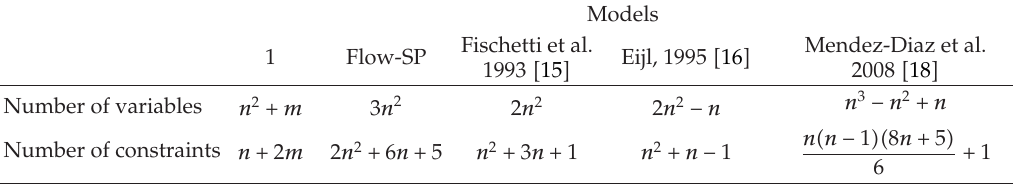
Table 2: Total number of decision variables and constraints of models proposed for TRP. Models Flow-SP